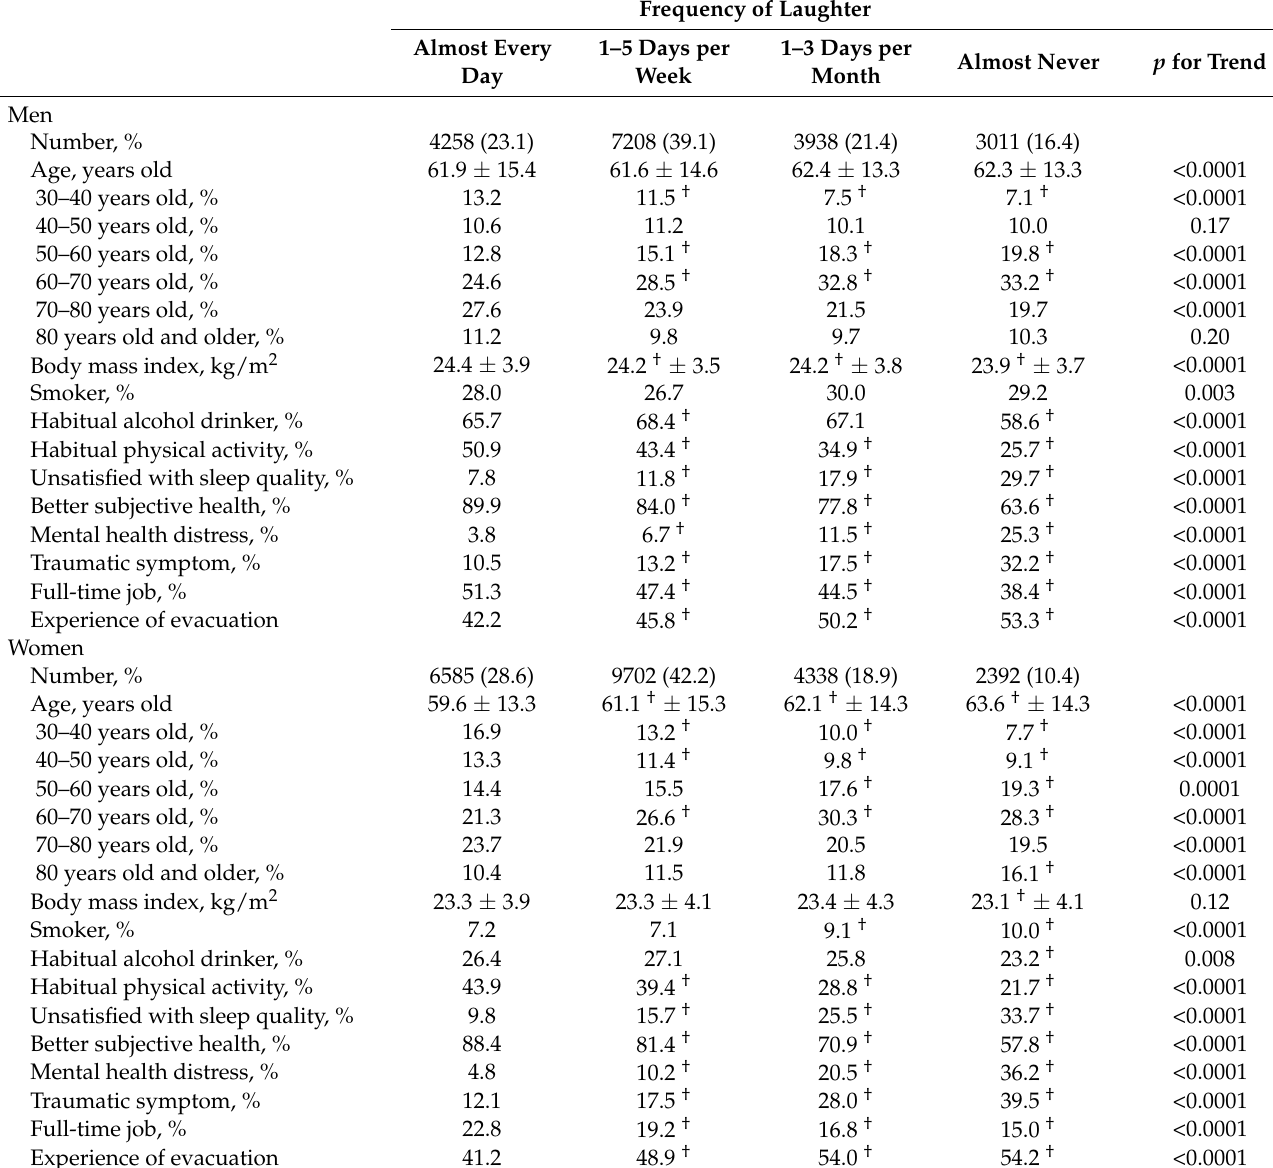
Table 1. Gender-specific means and proportions of characteristics for participants according to the frequency of laughter. Frequency of Laughter Almost Every